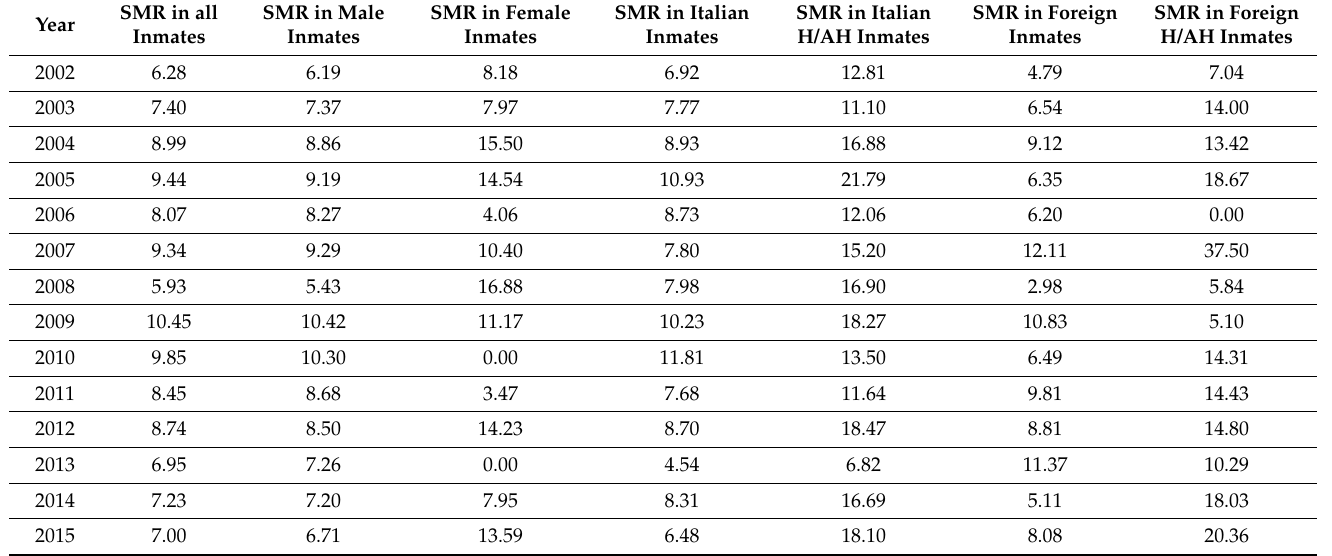
Table 2. The Suicide Mortality Rate (SMR per 10K.) among all inmates’ population in Italy and specific category (total and Homicide/attempted homicide) per year (from 2002 to 2015) considering gender and